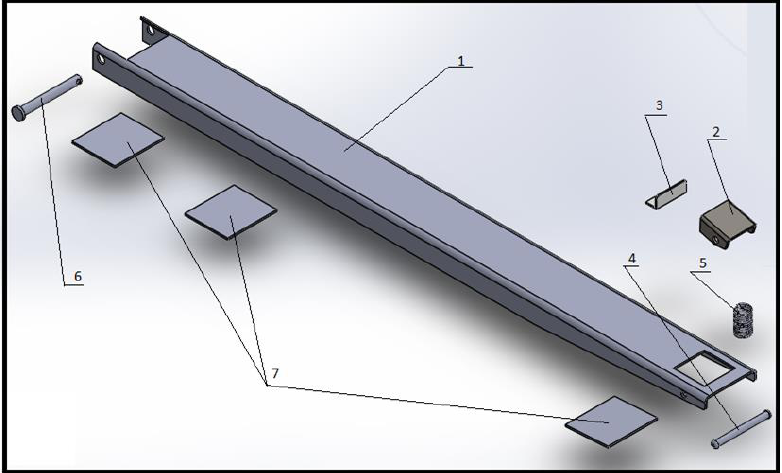
Figure 10. View of fork anti-slip pad: 1 — fork core, 2 — lock core, 3 — rear lock, 4 — front pin, 5 — spring, 6 — rear pin, 7 — pad base.